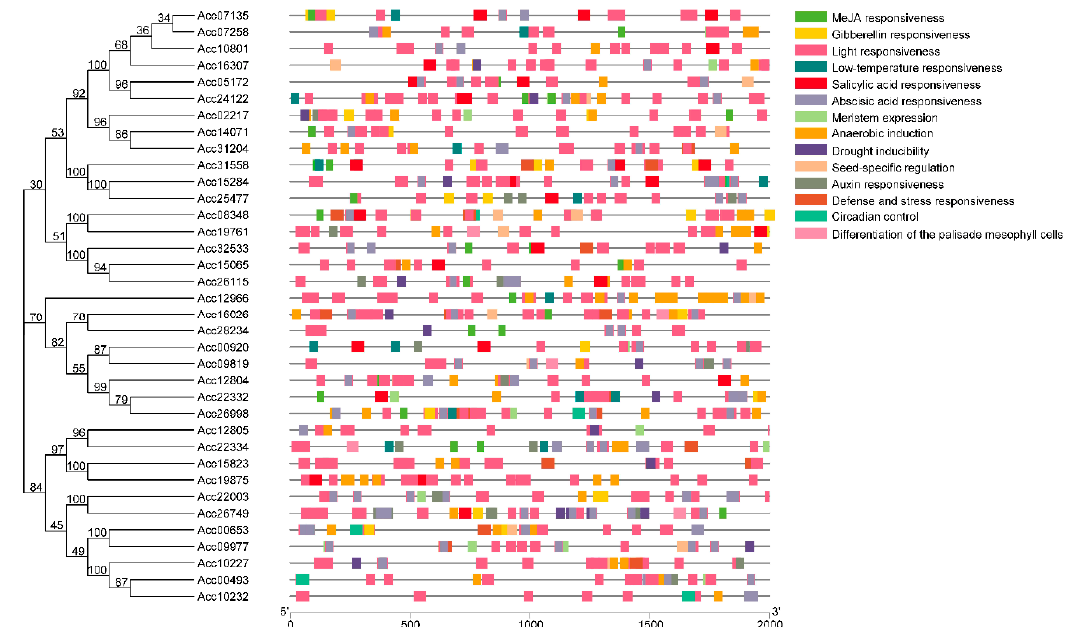
Figure 2. Distribution of cis-acting regulatory elements (CREs) involved in the responsiveness and development of the promoters of 36 candidate AccR2R3-MYBs.